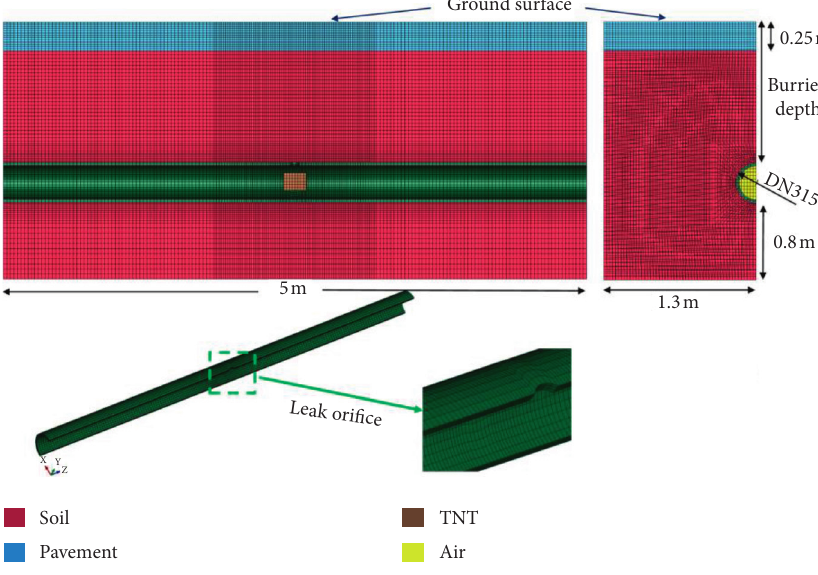
Figure 1: Schematic of the physical model.